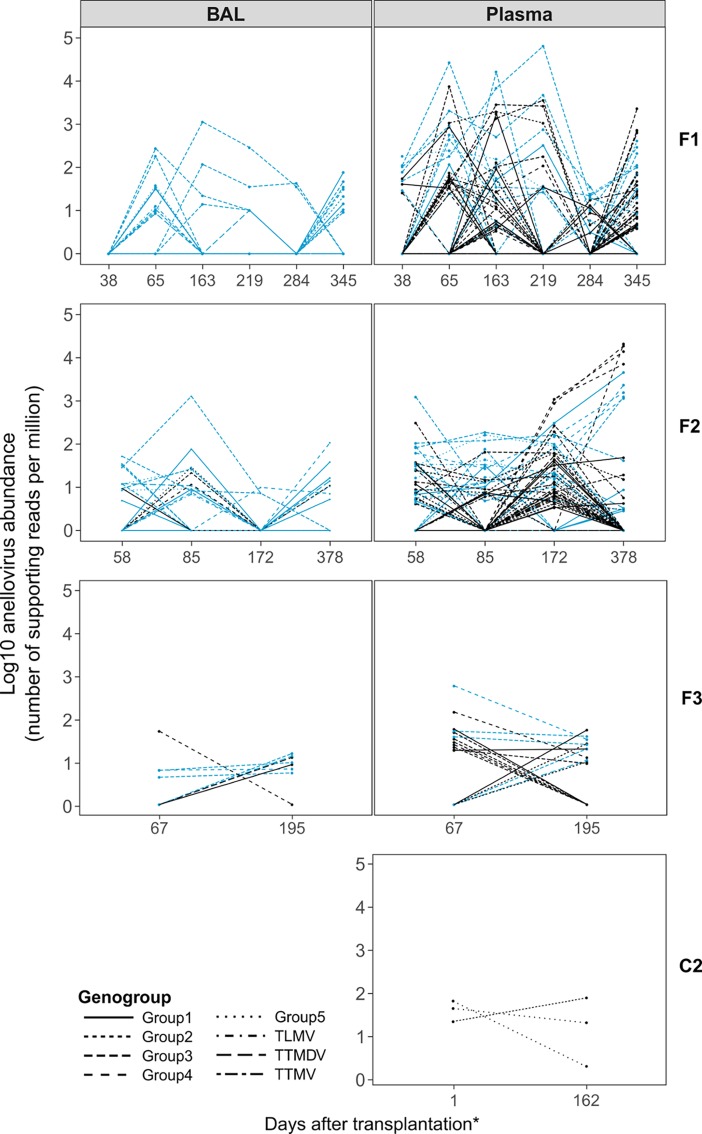
Within patient anellovirus isolates present at each time point after transplantation in BALs and plasma samples of LTRs (F1-F3).C2 is a healthy control sample. *For C2, y-axis indicates day at which sample was taken. Blue lines: anellovirus strains detected simultaneously in BAL and plasma. Black lines: anellovirus strains present in only one body compartment.